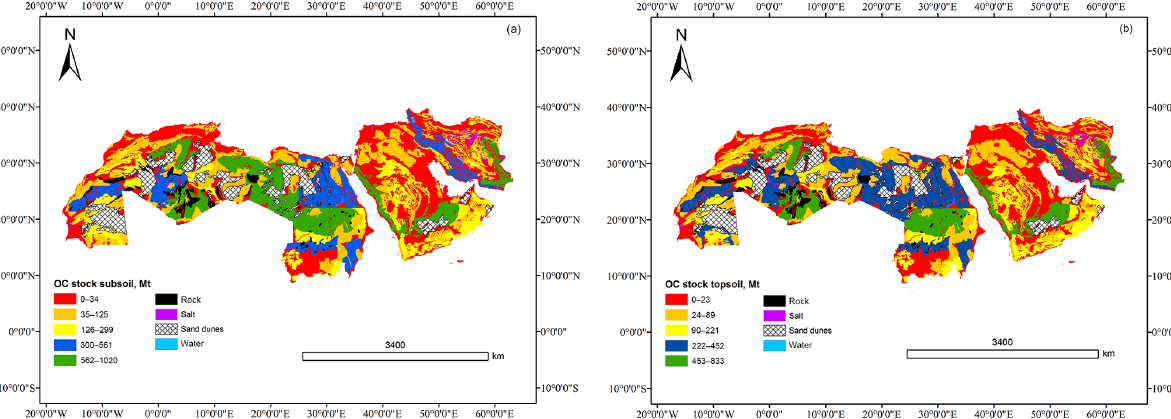
Figure 4. Spatial view of total soil organic carbon stock (Mt) across the countries and territories of the NENA region ( a : topsoil; b :